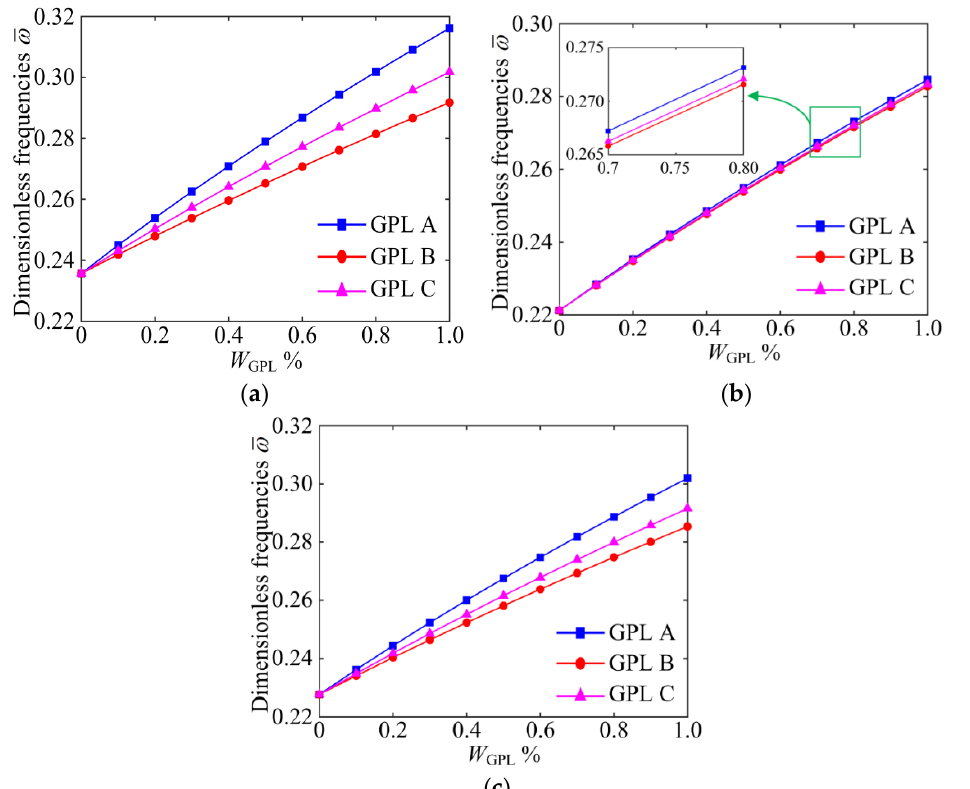
Figure 9. The influences of GPL weight fraction on dimensionless fundamental frequencies of the GPLRP, two-cylindrical-panel system (SSSS). ( a ) Porosity-I; ( b ) Porosity-II; ( c ) Porosity-III.